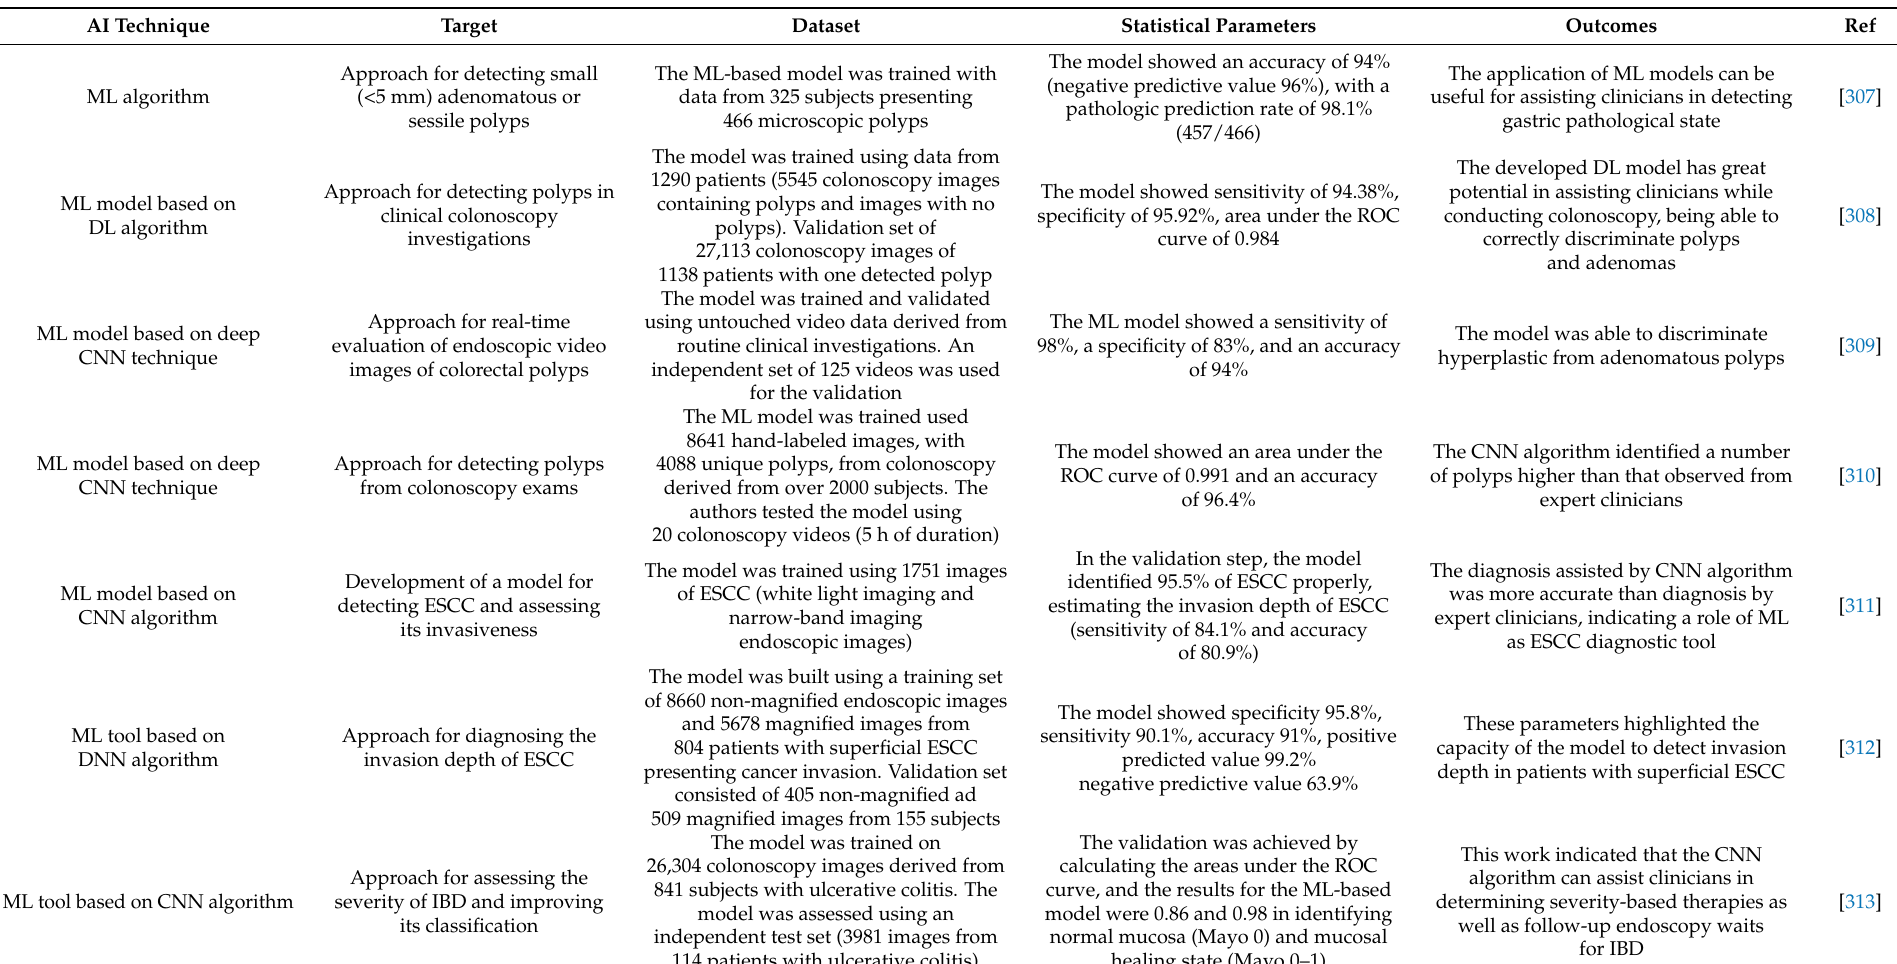
Table 8. Main examples of AI/ML in